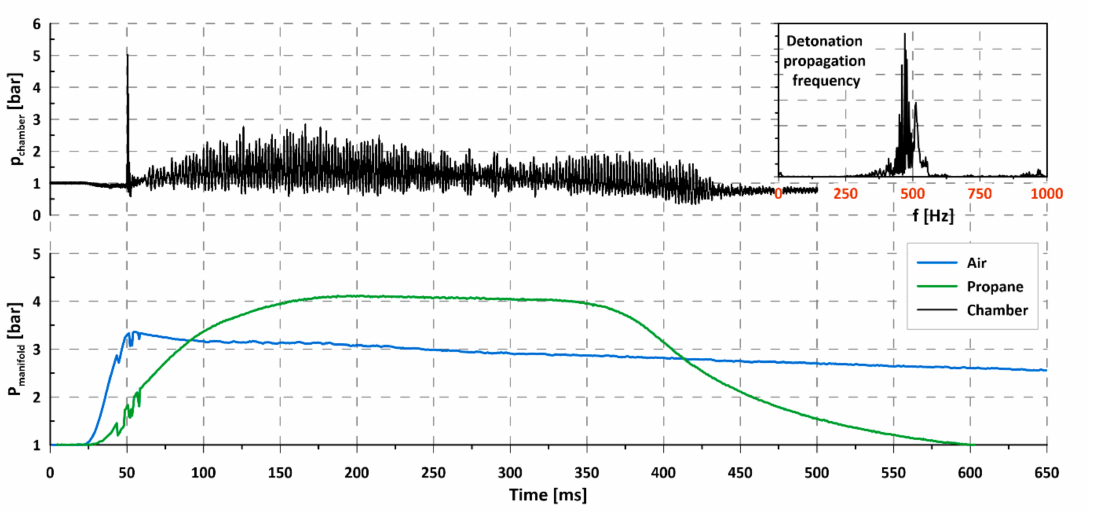
Figure 10. Propagation of rotating detonation for propane–air